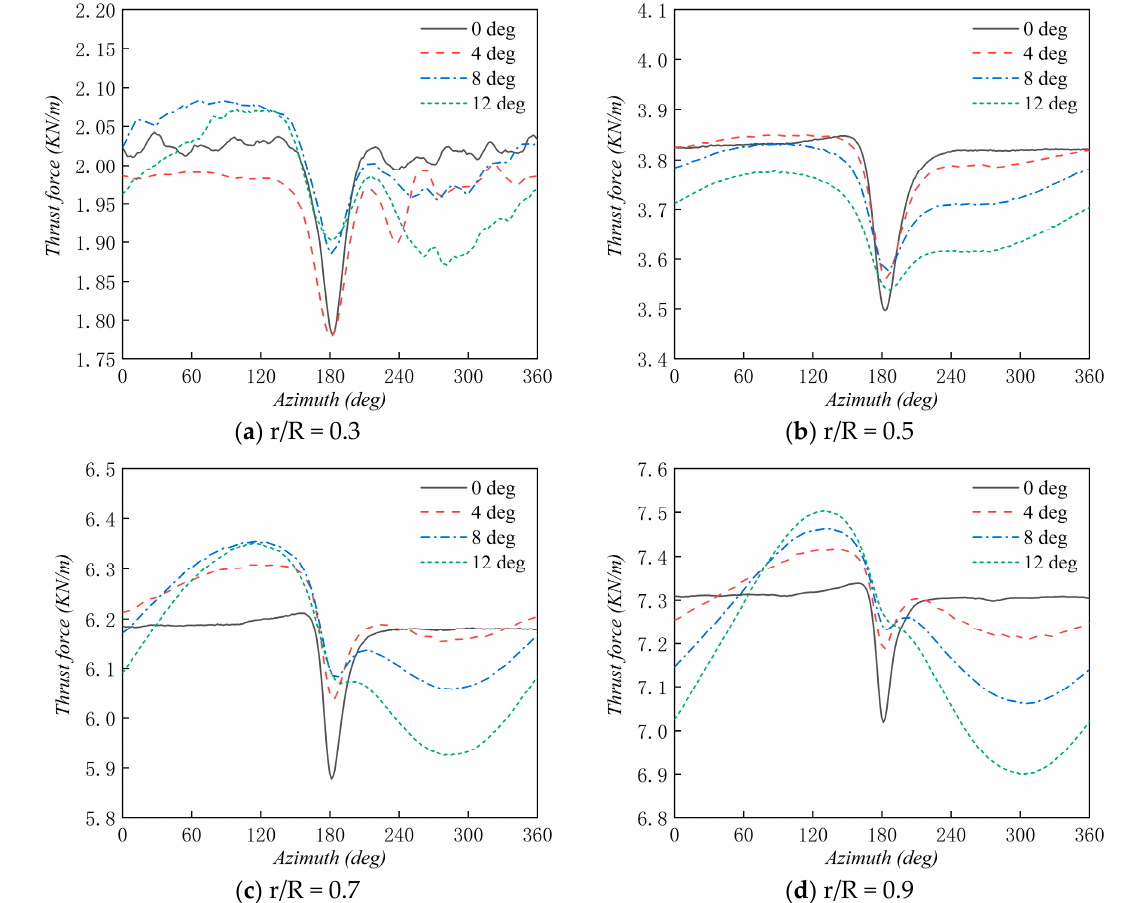
Figure 17. Thrust force per unit of span along the rotor span for Blade 1.